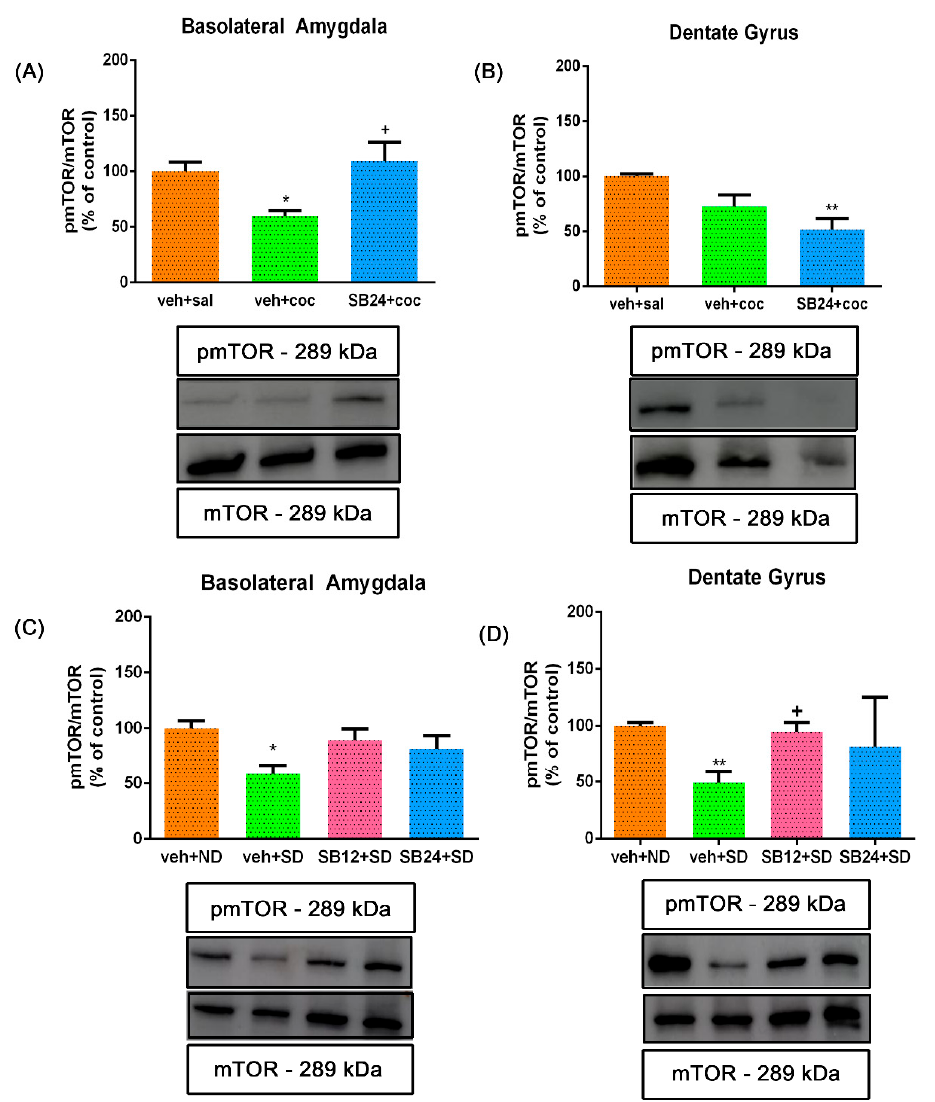
Figure 5. Semiquantitative analysis and representative immunoblot of phosphorylated (activated) mTOR (pmTOR) protein expression in the basolateral amygdala ( A , C ) and dentate gyrus ( B , D ). All the animals were conditioned to cocaine preference and underwent through abstinence for 60 days. ( A , B ) show the cohort of animals that were administered with saline (veh+sal; controls), with a dose of cocaine prime (veh+coc) or with an injection of the D3DR antagonist SB-277011-A (24 mg/kg i.p.) prior to the cocaine-priming (SB24+coc). * p < 0.05, ** p < 0.01 vs. veh+sal. ( C , D ) represent the set of animals that were injected with vehicle and exposed to a non-defeated agonistic encounter (veh+ND; controls) or exposed to an agonistic encounter with social defeat (veh+SD). Additionally, a group of animals was injected with the D3DR an- tagonist SB-277011-A (12 or 24 mg/kg i.p.) prior to the social-defeated agonistic encounter (SB12+SD and SB24+SD, respec- tively). A preference test was conducted by giving free access to both compartments of the CPP apparatus for 15 min to every group of animals. * p < 0.05, ** p < 0.01 vs. veh + ND; + p < 0.05 vs. veh+SD. Each bar corresponds to mean ± standard error of the mean (n = 5–8 per group).